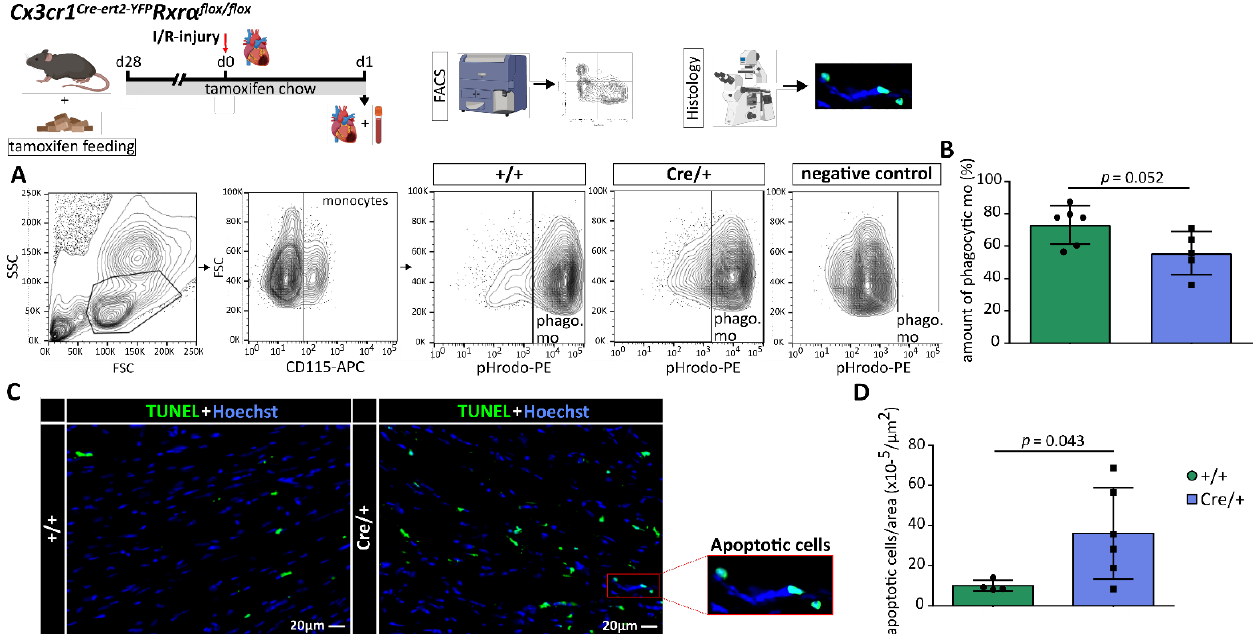
Figure 4. Reduction of Rxrα expression in myeloid cells impairs their phagocytic function and is associated with an increase in apoptotic cells after I/R injury. ( A ) FACS gating strategy to analyze the phagocytic function of PB monocytes; ( B ) comparison of the phagocytic activity of PB monocytes from Cx3cr1ΔRxrα and control mice; ( C ) co-staining of apoptotic cells using an ApopTag Plus Fluorescein In Situ Apoptosis Detection Kit and the nuclear counterstain Hoechst; ( D ) quantification of apoptotic cells per area in the heart of Cx3cr1ΔRxrα compared to control mice on d1 after MI. Flowchart was created with BioRender.com. control (+/+): control mice [littermates with a floxed Rxrα allele but without Cre expression]; Cx3cr1ΔRxrα (Cre/+): mice with a floxed Rxrα allele and Cre expression; FACS: fluorescence activated cell sorting; FSC: forward scatter; I/R injury: Ischemia/Reperfusion injury; mo: monocytes; phago.: phagocytic; Rxr: Retinoid X receptor; SSC: sideward scatter.